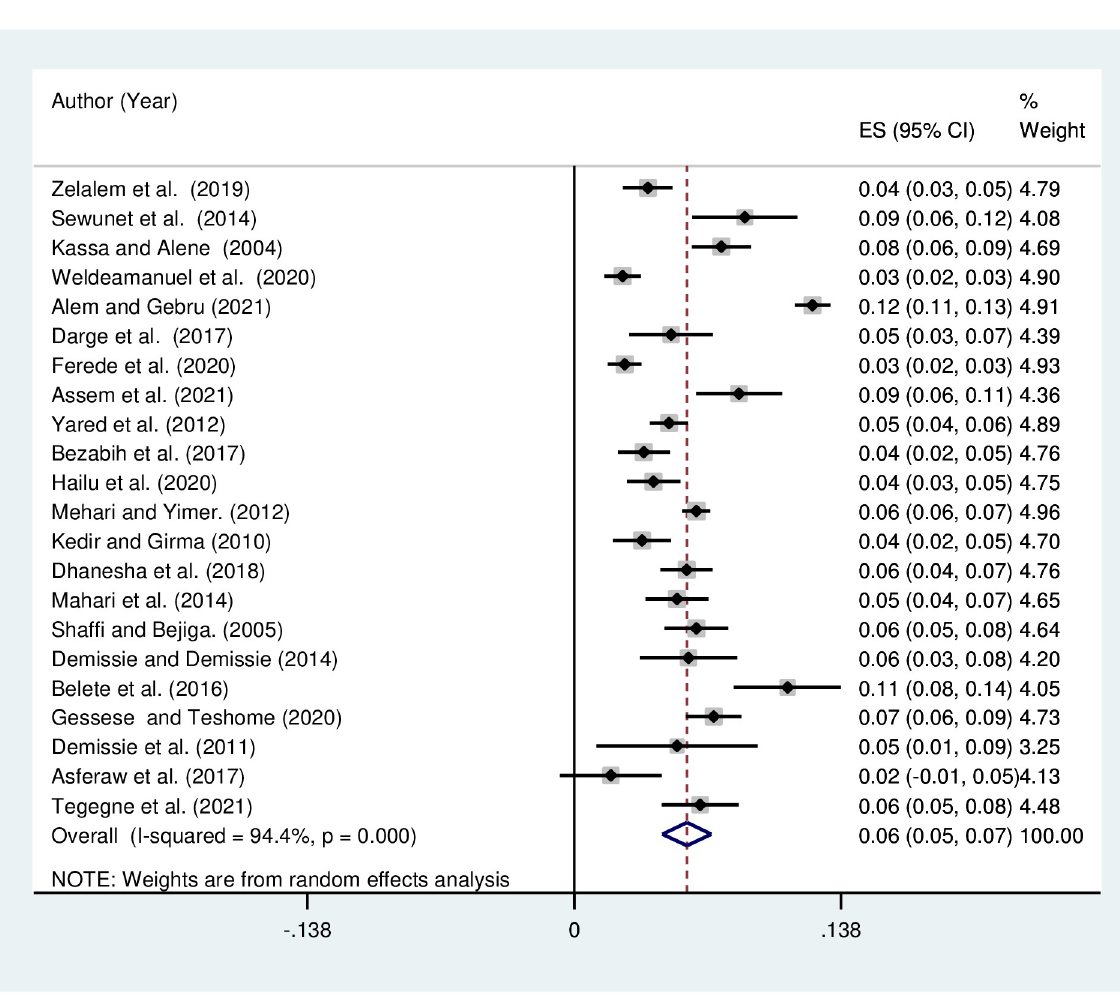
Fig 4. Funnel plot showing the pooled prevalence of visual impairment due to refractive error in Ethiopia, 2021.